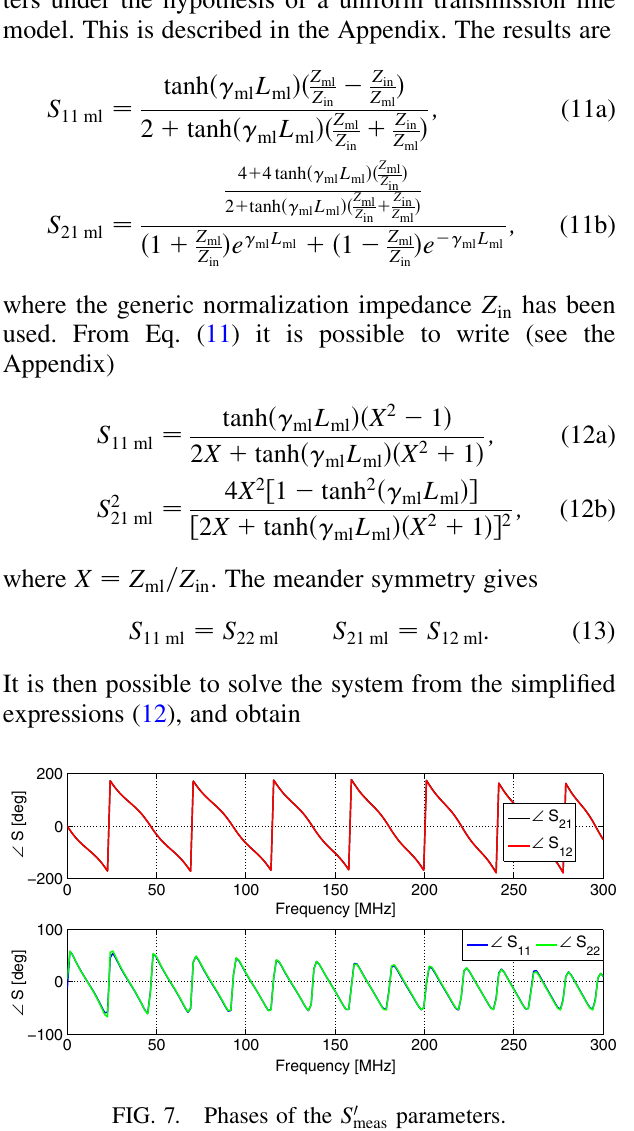
FIG. 7. Phases of the S 0 meas